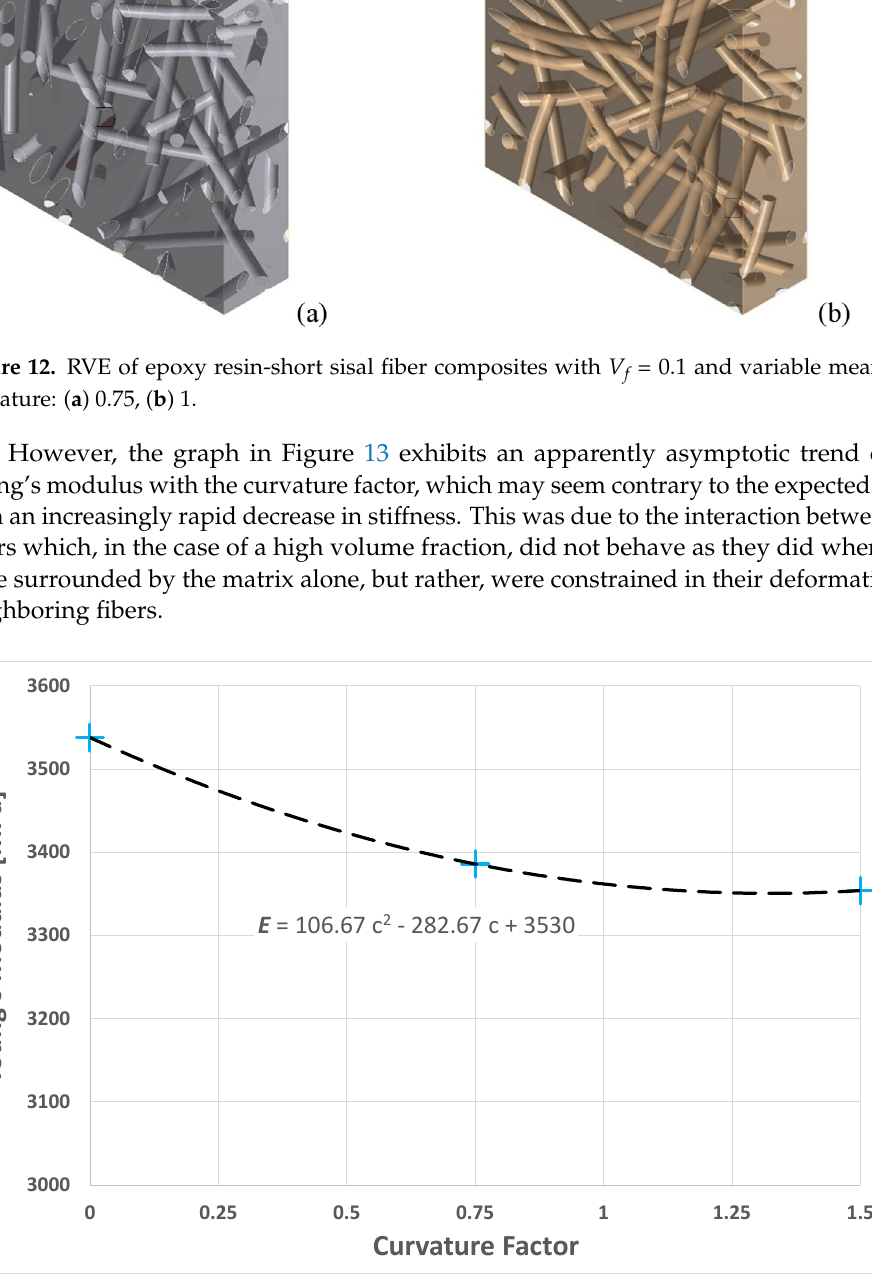
Figure 12. RVE of epoxy resin-short sisal fiber composites with V f = 0.1 and variable mean fiber curvature: ( a ) 0.75, ( b ) 1.